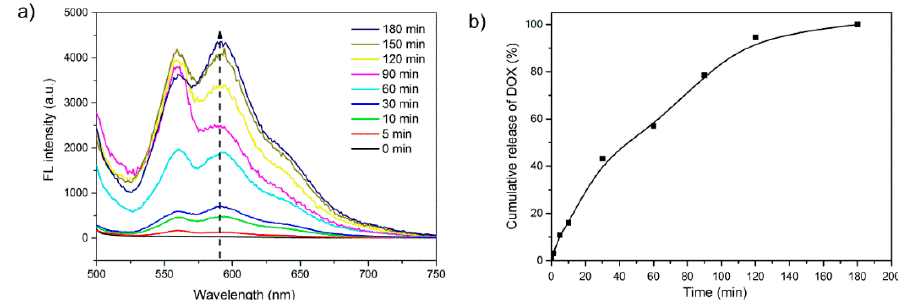
Figure 9. ( a ) Fluorescence (FL) spectra of the micelles in PBS solution upon treatment with H 2 O 2 (33 mM). ( b ) Cumulative doxorubicin (DOX) release from DOX-loaded PS-Se-1- b -PEGMA 950 micelles.